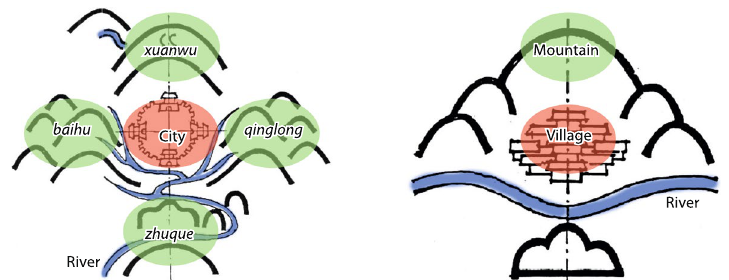
Fig. 4 Traditional Chinese site selection concept, based on fengshui theory (Source: Wang and Zhang